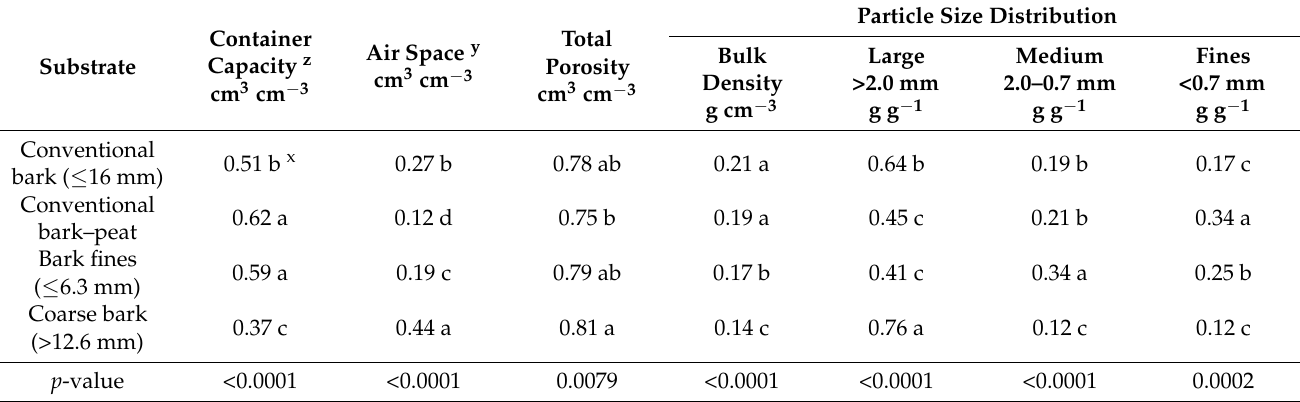
Table 1. Physical characteristics of the four substrate components used to design the control and stratified substrates as determined by using a porometer and sieving dry